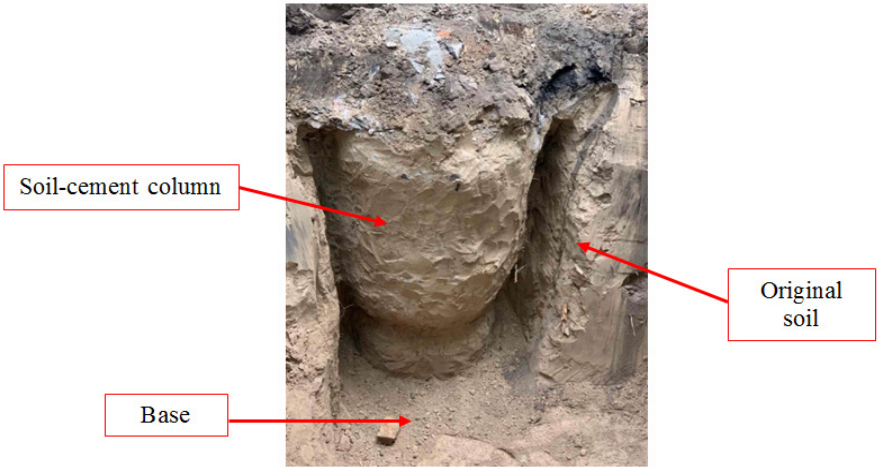
Figure 3. The general view of the soil–cement column (source: authors).